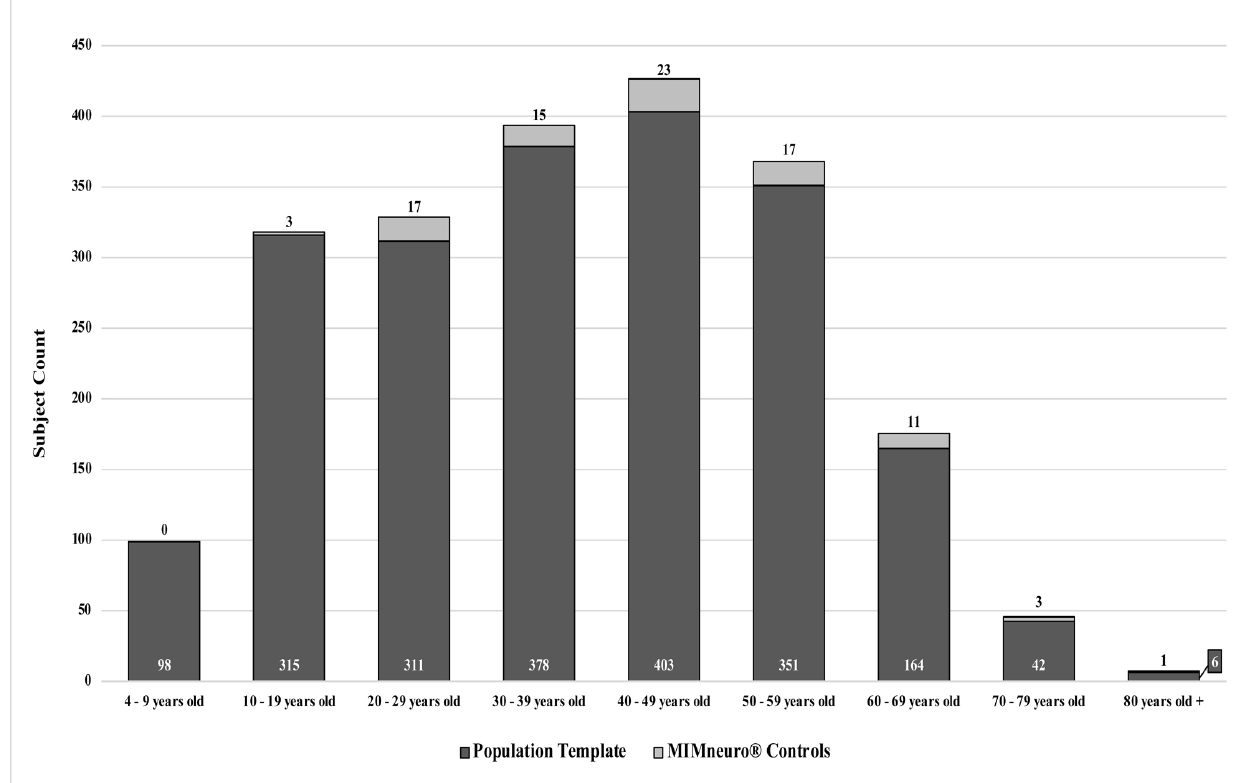
Figure 1. Age distribution of subjects in population template versus the controls contained within MIMneuro